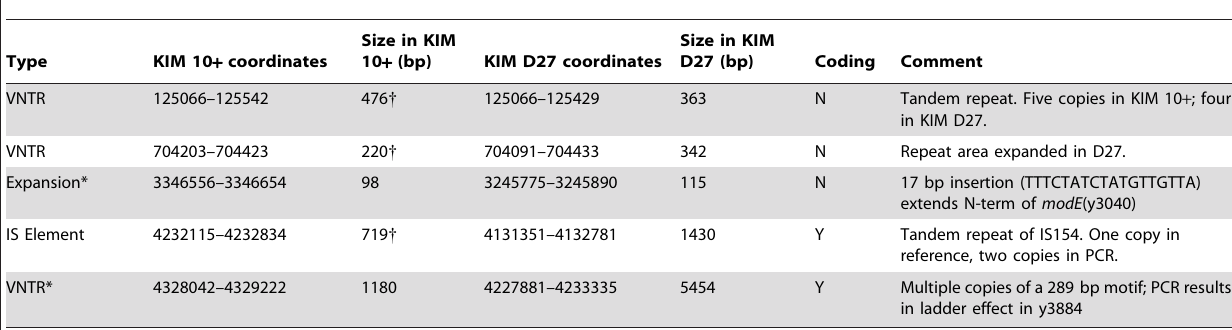
Table 2. Repeat expansion or reduction in Y. pestis KIM